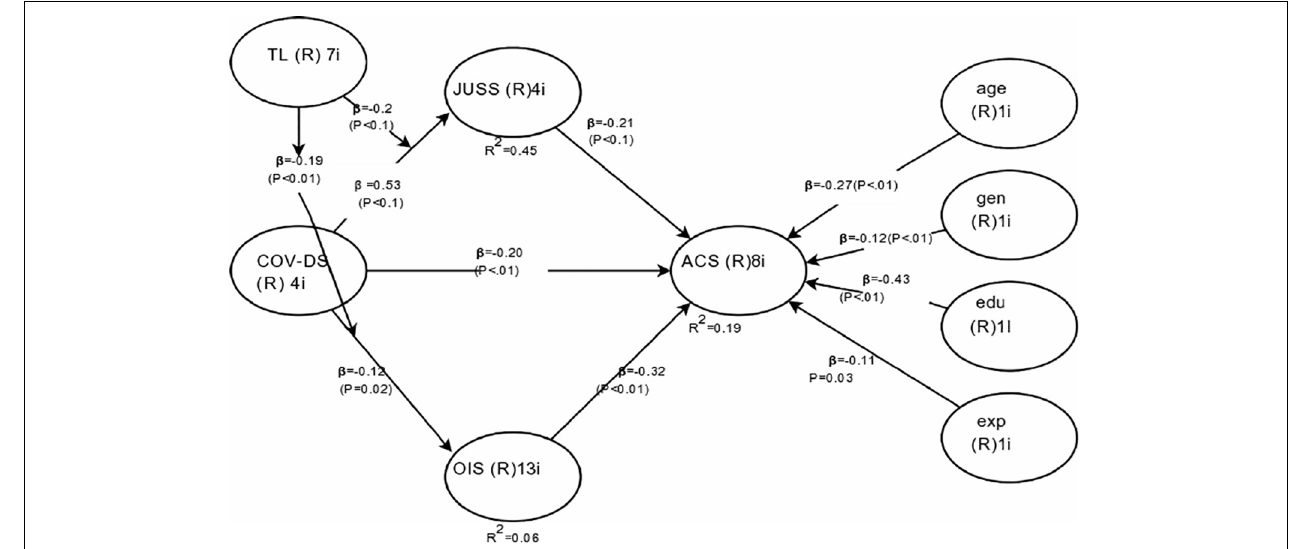
FIGURE 3 | Theoretical framework of the